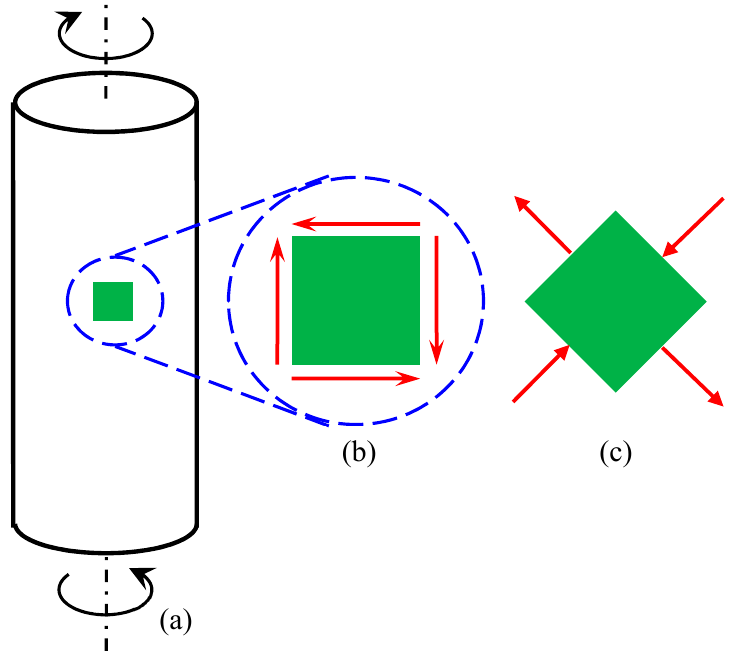
Figure 1. Schematics for ( a ) a rod under torsion, ( b ) an elemental volume under pure shearing, and ( c ) an equivalent stress state at 45° showing in-plane principal stresses. Red arrows indicate stress directions.